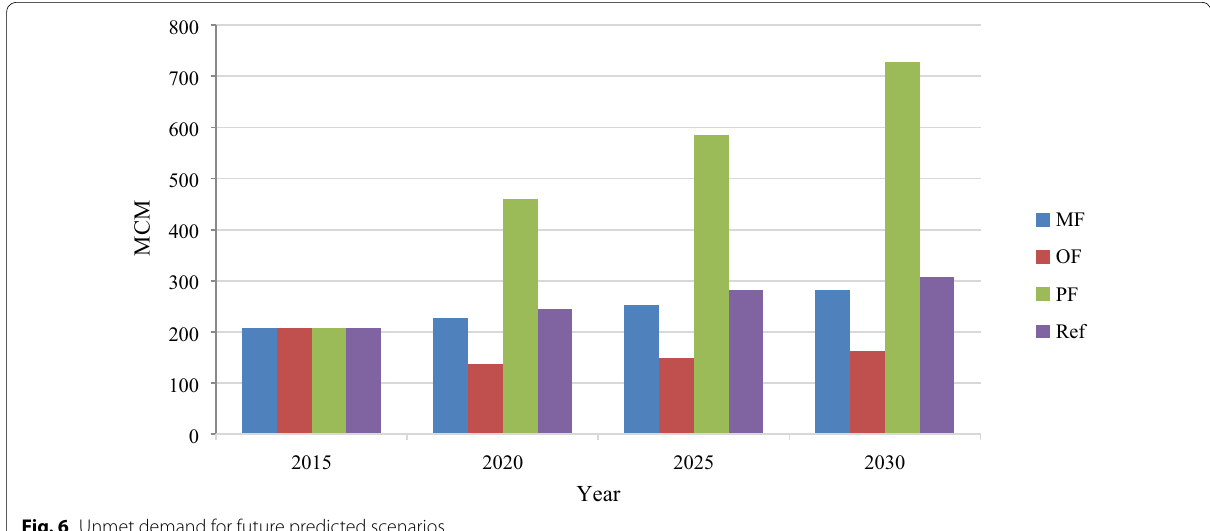
Fig. 6 Unmet demand for future predicted